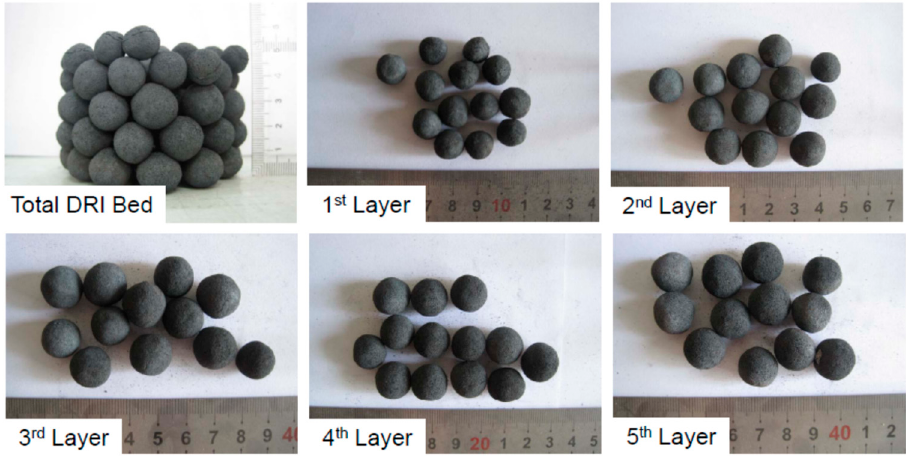
Figure 6. Appearances of the total direct reduced iron (DRI) bed and each layer.